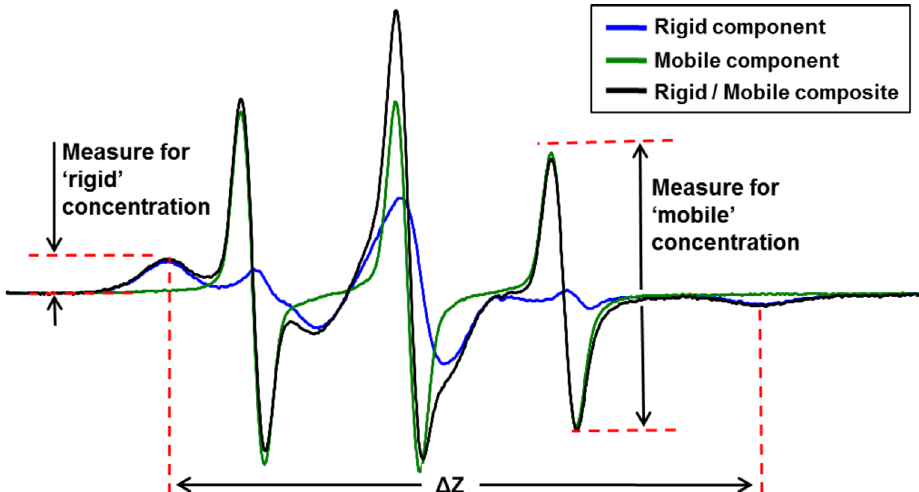
Figure 1. ESR SL spectra of a 64 kDa protein (BSA) spin-labeled at a “ mobile ” site (green line) or at a rigid site (blue line). The third, “ composite ” ESR “ spectrum ” (black line) is obtained by summation of the mobile and rigid spectra. This composite spectrum is SL typical for the case where both rigid and mobile populations are present. Key areas of the composite spectrum re fl ect only the contributions of either the rigid or mobile population, so they can be quanti fi ed independently: the height of the low- fi eld (left most) ESR SL peak varies in proportion to the rigid population, and the height of the sharp, high- fi eld peak varies in proportion to the mobile population. Furthermore, the parameter D Z is a qualitative metric for the nature of the rigid